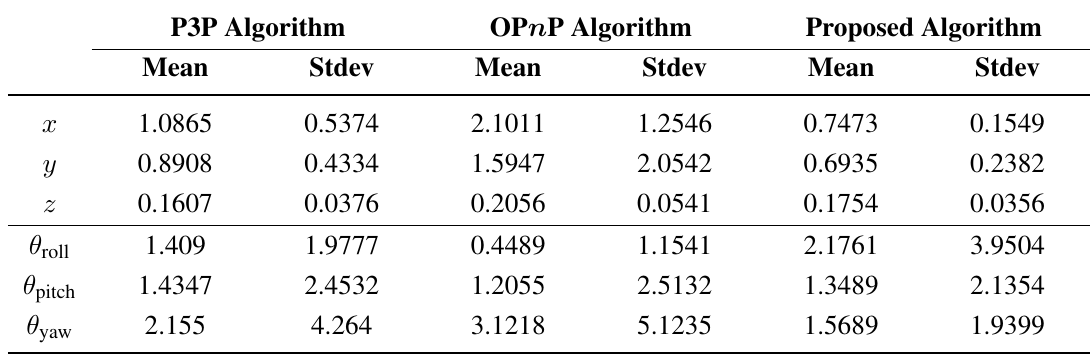
Table 3. Comparison of the error statistics of the conventional and the proposed algorithms in the outdoor environment (Unit: m,